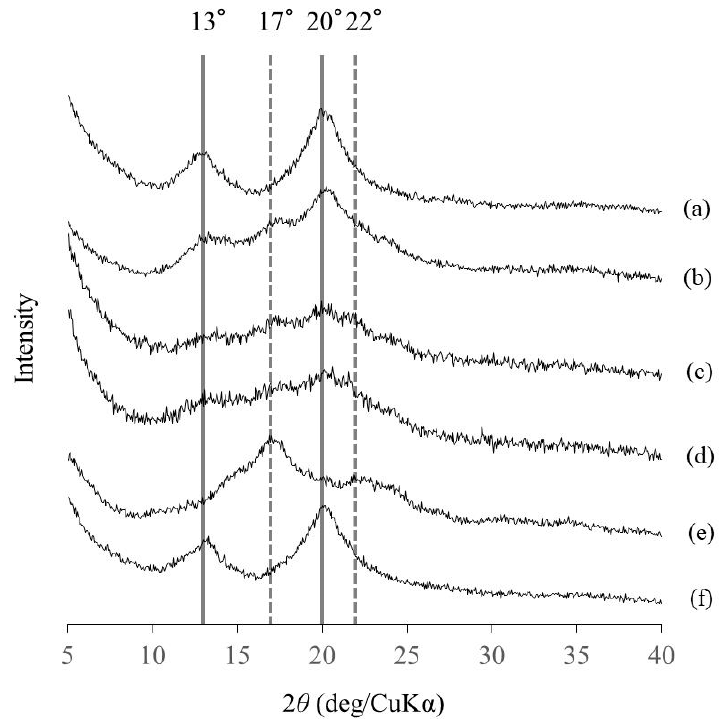
Figure 2. X-ray diffraction (XRD) profiles of ( a – d ) products by lyophilization of runs 1–4, ( e ) enzymatically synthesized amylose, and ( f ) amylose-PCL inclusion complex.